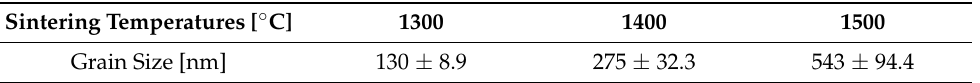
Table 3. Grain sizes of 4Y-PSZ disks sintered at various temperatures (1300 °C, 1400 °C, and 1500 °C).